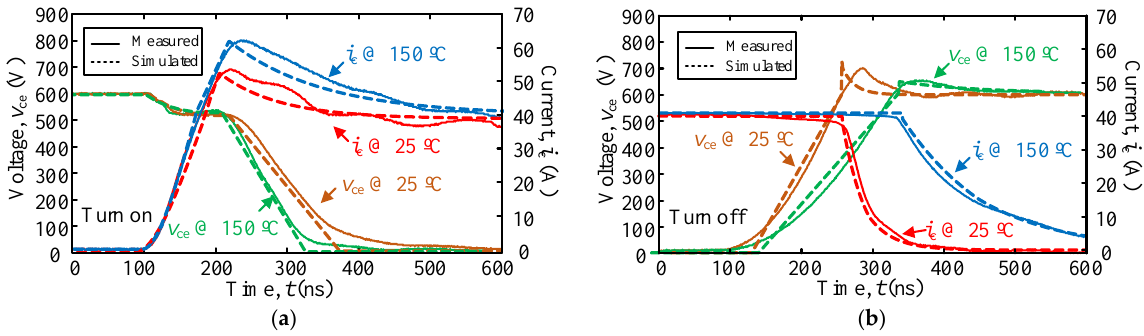
Figure 10. Switching waveforms of Si IGBTs ( a ) turn-on; ( b ) turn-off; @ 𝑅 G = 15 Ω .